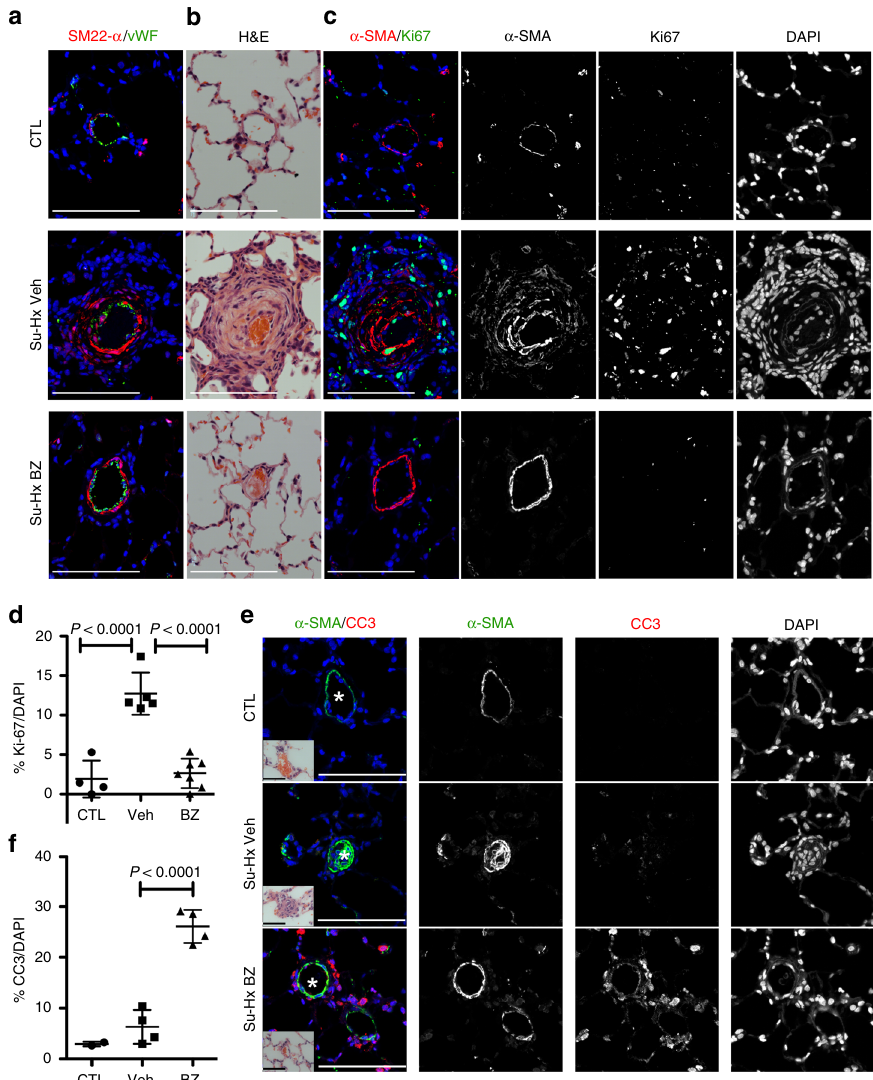
Fig. 5 Benzarone reduces proliferation and increases apoptosis in the pulmonary vasculature. a – c BZ treatment reduces muscularization and cell proliferation in rat lungs subject to the Su-Hx protocol. Serial lung sections were stained with ( a ) antibodies to SM22- α (SMC marker) and von Willebrand factor (vWF; endothelial cell marker), and with the nuclear marker DAPI, ( b ) H&E, ( c ) antibodies to α -SMA and Ki-67 to identify proliferating SMC, and with the nuclear marker DAPI. Scale bar = 100 μ m. d Quantitation of the percentage of Ki-67-positive cells. Each data point represents at least eight sections per lung. CTL rats maintained in room air n = 4, VEH vehicle-treated animals subject to the Su-Hx protocol n = 5, BZ-treatment protocol n = 7. Data plotted as the mean ± SD, statistical signi fi cance determined by one-way ANOVA. e BZ induces apoptosis in lungs subject to the Su-Hx protocol. Lung sections were stained with antibodies to cleaved caspase-3 (CC3; an apoptosis marker) and to α -SMA; scale bar = 100 μ m. H&E staining of serial sections showing blood vessels indicated by an asterisk are inset; scale = 50 μ m. f Quantitation of the percentage of apoptotic cells. Each data point represents at least four sections per lung. CTL rats maintained in room air n = 2, VEH vehicle-treated animals subject to the Su-Hx protocol n = 4, BZ-treatment n = 4. Data plotted as the mean ± SD, statistical signi fi cance determined by one-way ANOVA. Source Data are provided as a Source Data fi